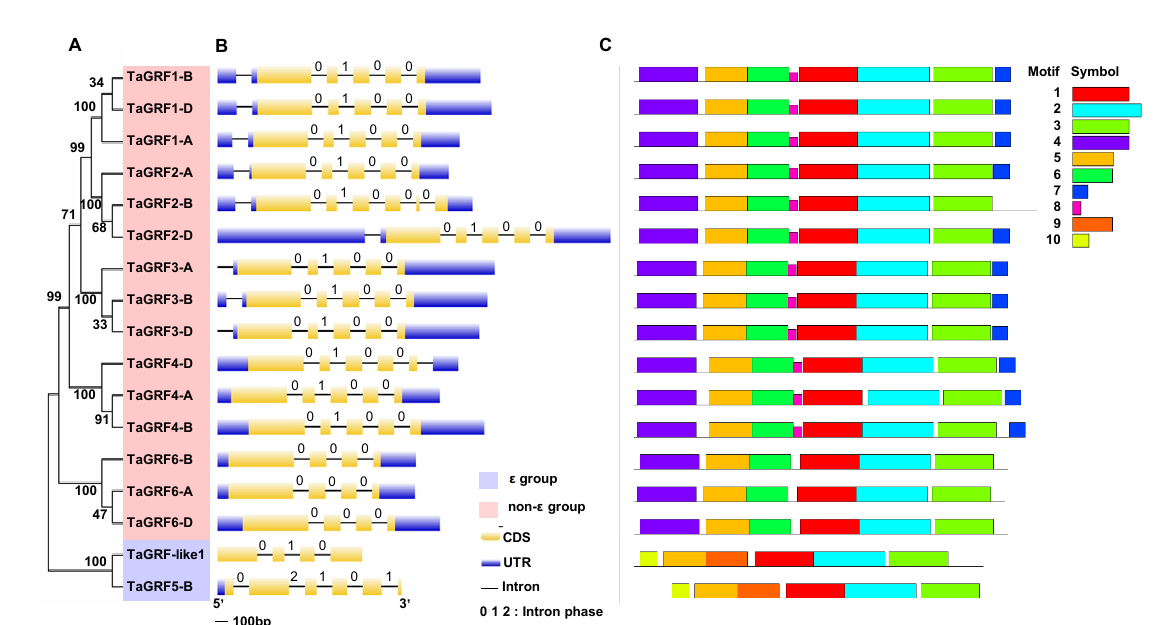
Figure 1. Structural analysis of TaGRFs . ( A ) The phylogenetic tree of TaGRFs . ( B ) Gene structure analysis of TaGRFs was conducted using the GSDS database. All introns are shown the same length. ( C ) Motif analysis of TaGRFs was identified by MEME. Motif components in the amino acid sequence of TaGRFs are displayed using MAST. Different motifs were represented in different color blocks.